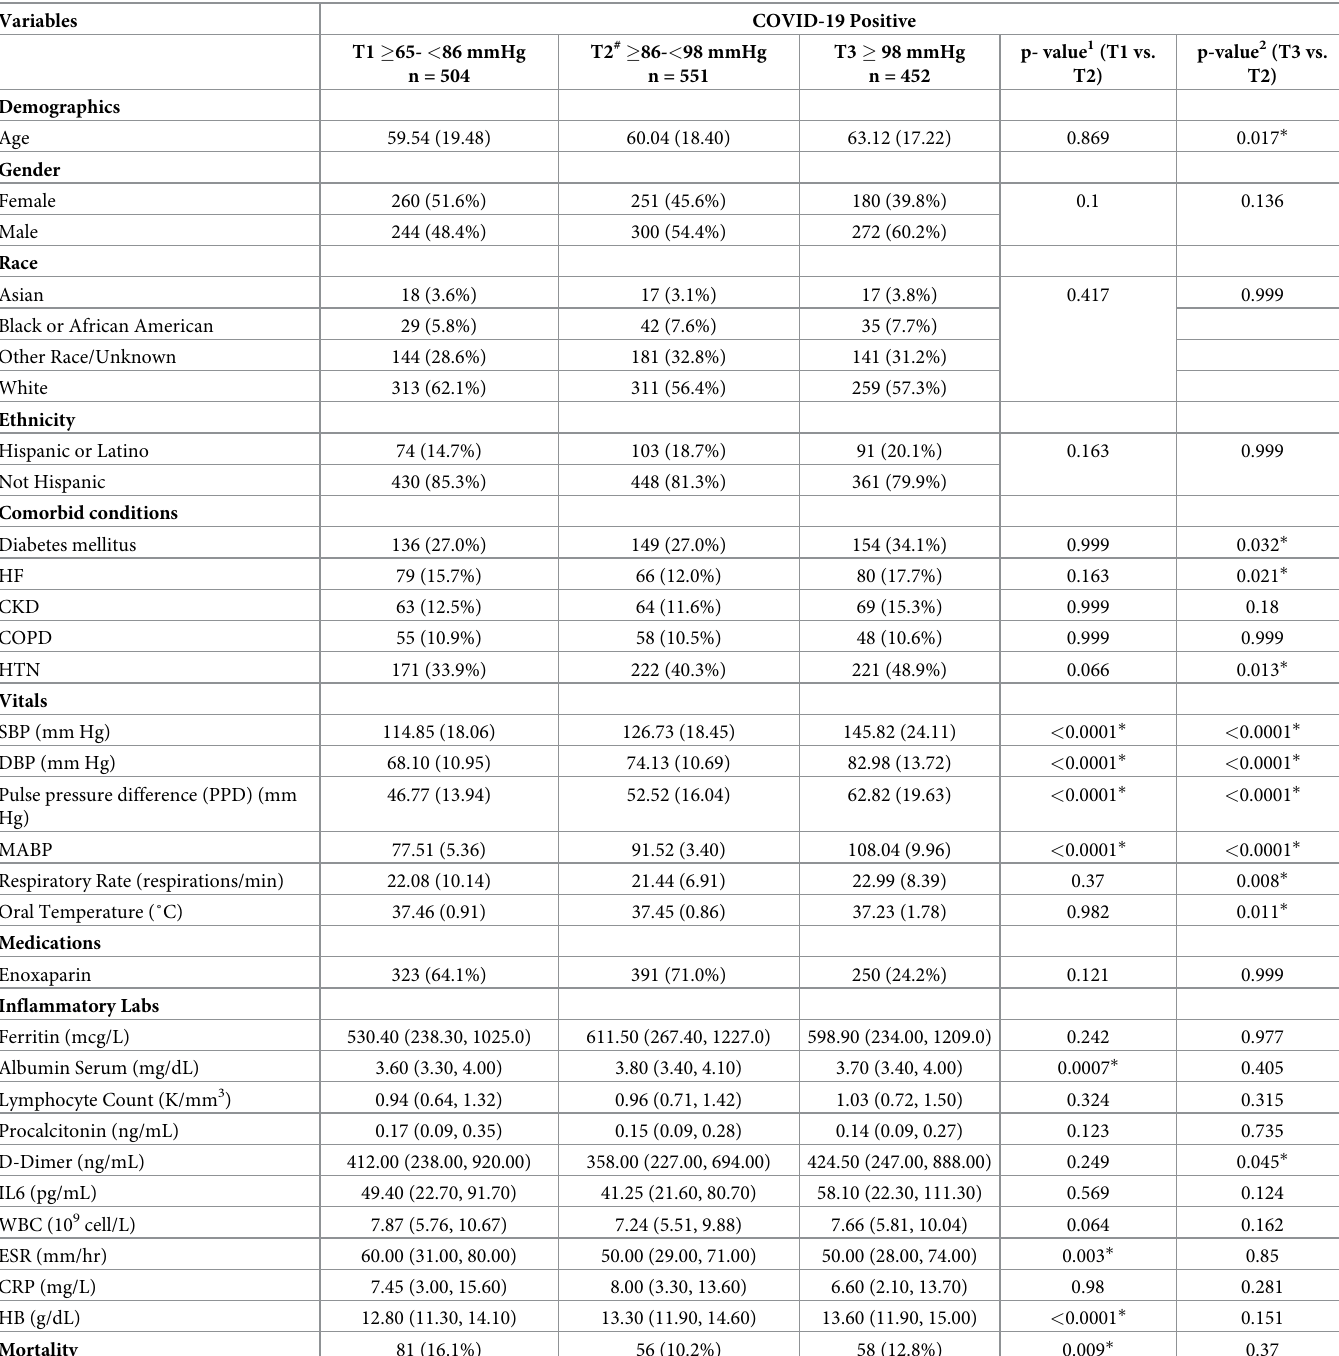
Table 2. Comparison of MABP Tertiles in hospitalized COVID-19 positive